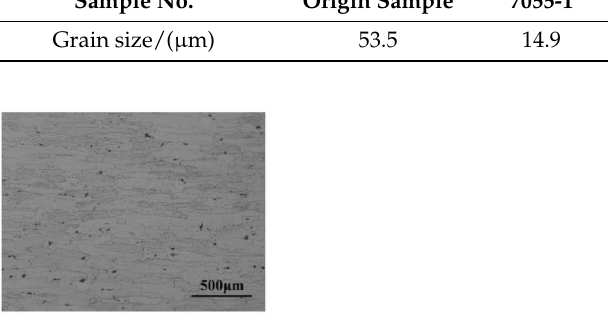
Figure 2. Microstructure of sample before rolling.